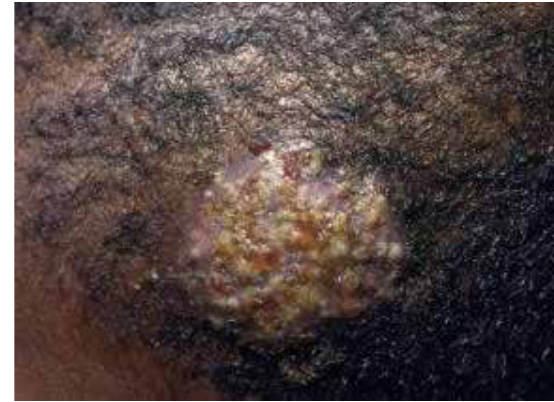
Figure 4. Tinea capitis kerion (Image available from http://doctorv.ca/medical-conditions/hair/